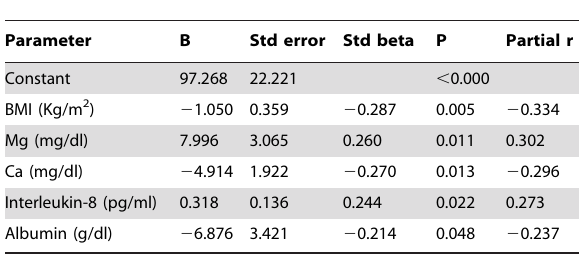
Table 2. Multiple regression analysis for assessing the predictors of serum adiponectin